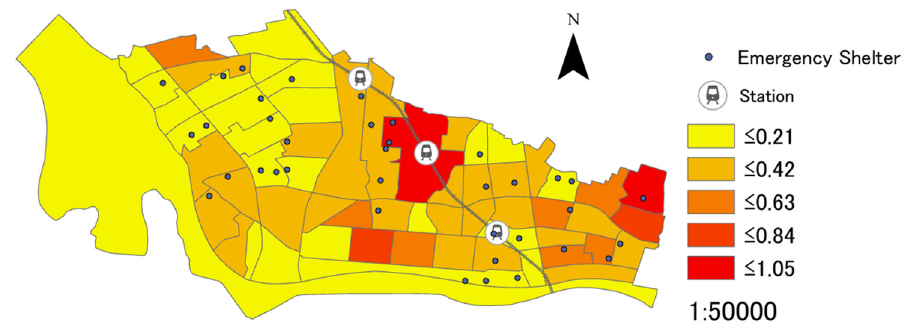
Figure 14. Result for Toda City with the ratio of elderly population as a weighted coefficient.